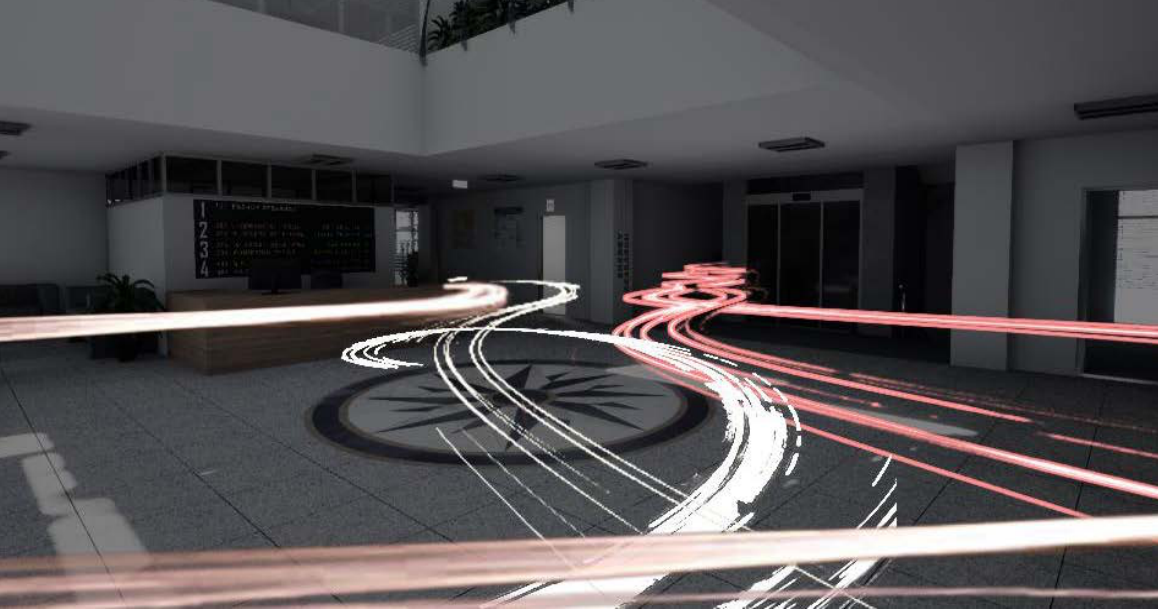
Figure 1: Occupants behaviour data